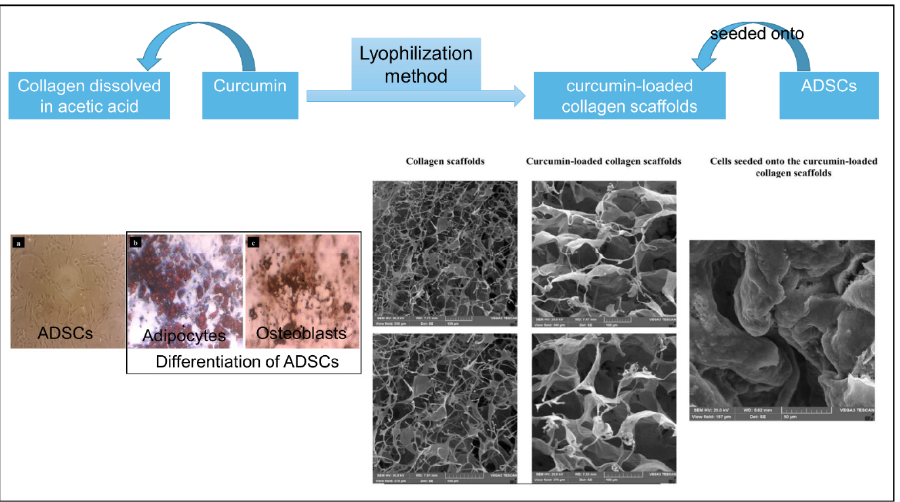
Figure 15. Collagen scaffold prepared by lyophilization method for the treatment of oral ulcers [31].